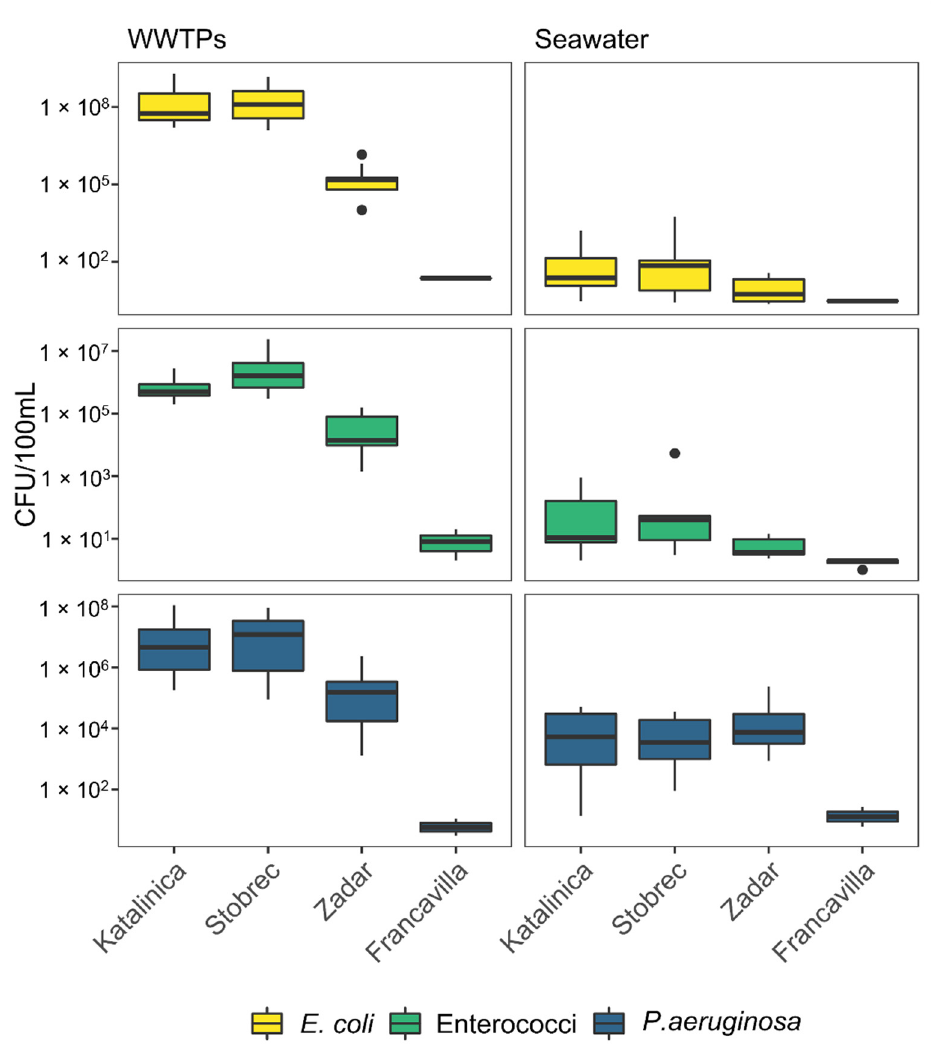
Figure 2. Box plots depicting the variation in microbiological counts (by membrane filtration method followed by plate cultivation) in treated sewage (WWTPs) and seawater samples. The median values ( − ), the first ( □ ), the third ( □ ), the minimum and maximum values (whiskers) and the outliers ( ● ) are shown.